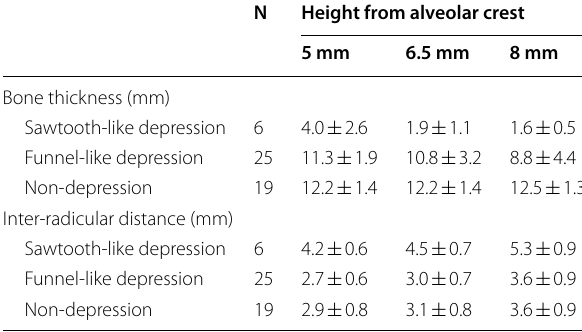
Values are shown as the mean